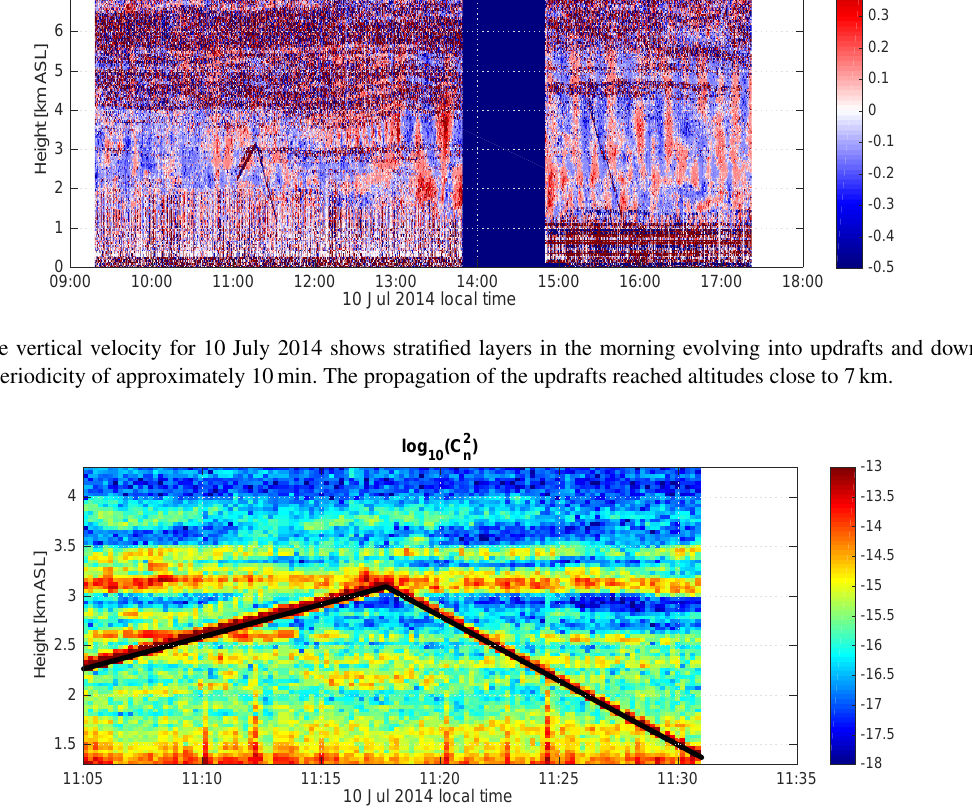
Figure 5. The black line represents the DataHawk altitude as a function of time plotted on top of the calibrated range-corrected received power for the morning flight (11:05–11:30). The DataHawk was dropped by a tethered balloon at an approximate altitude of 2.25km. In this case, there is an ascent from its initial altitude to 3km, followed by a descent over SOUSY down to